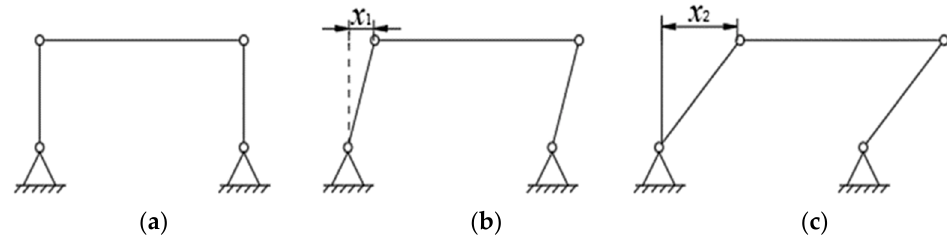
Figure 8. Deformation principle of flexible transmission parts. ( a ) System initial state sketch . ( b ) Sketch of system increasing preload state. ( c ) System output state sketch